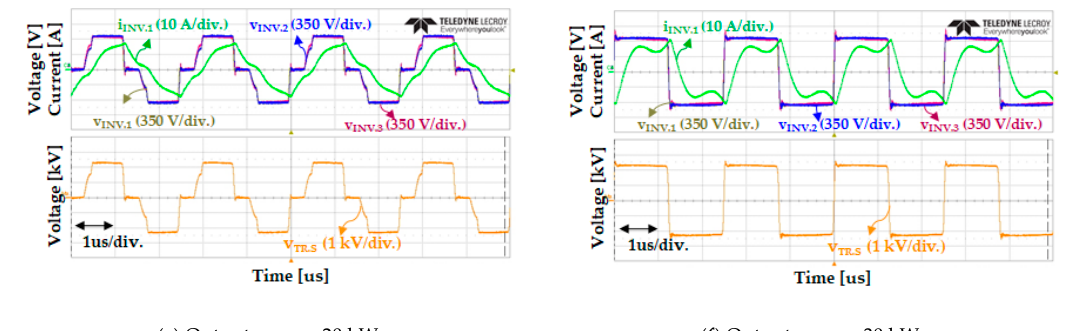
Figure 10. Waveforms of inverters according to control methods.